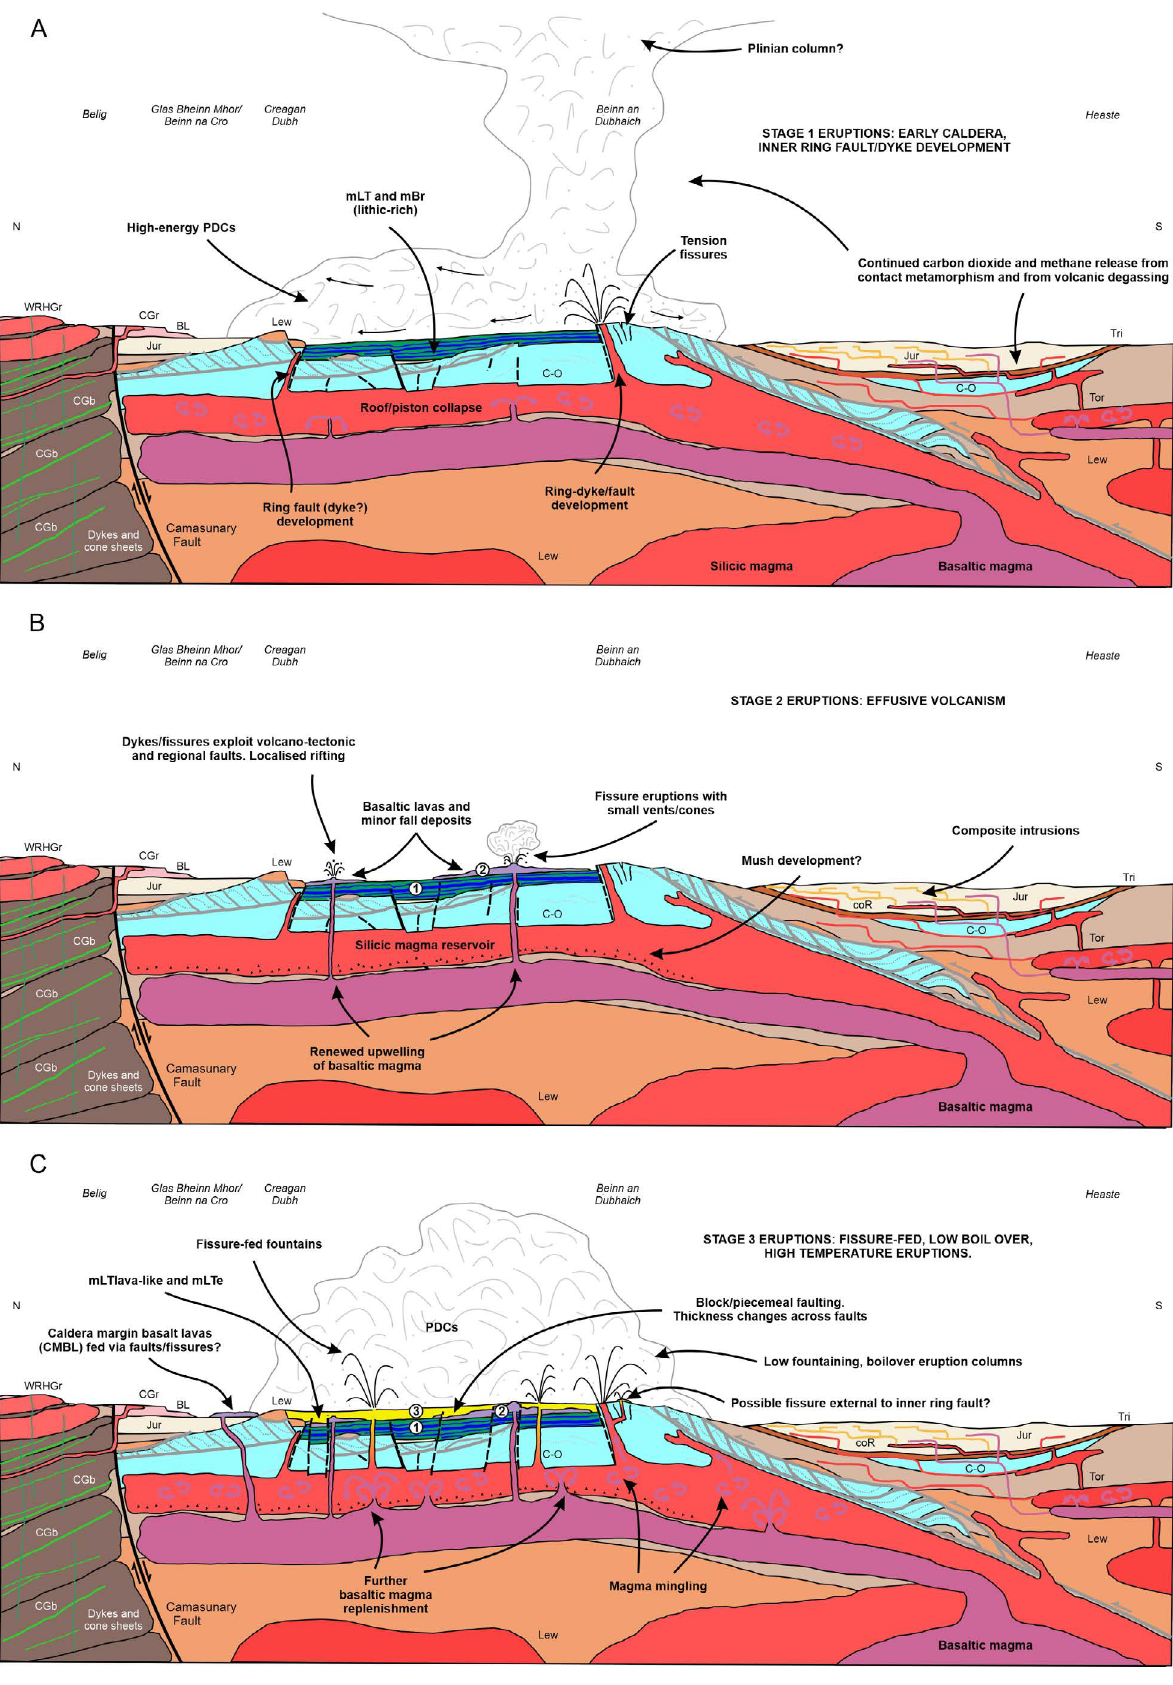
Figure 15: Stage 1–3 of KVF eruptions. [A] Early caldera, inner ring-fault and dyke development. [B] Effusive volcanism. [C] Fissure fed, low boil over, high temperature